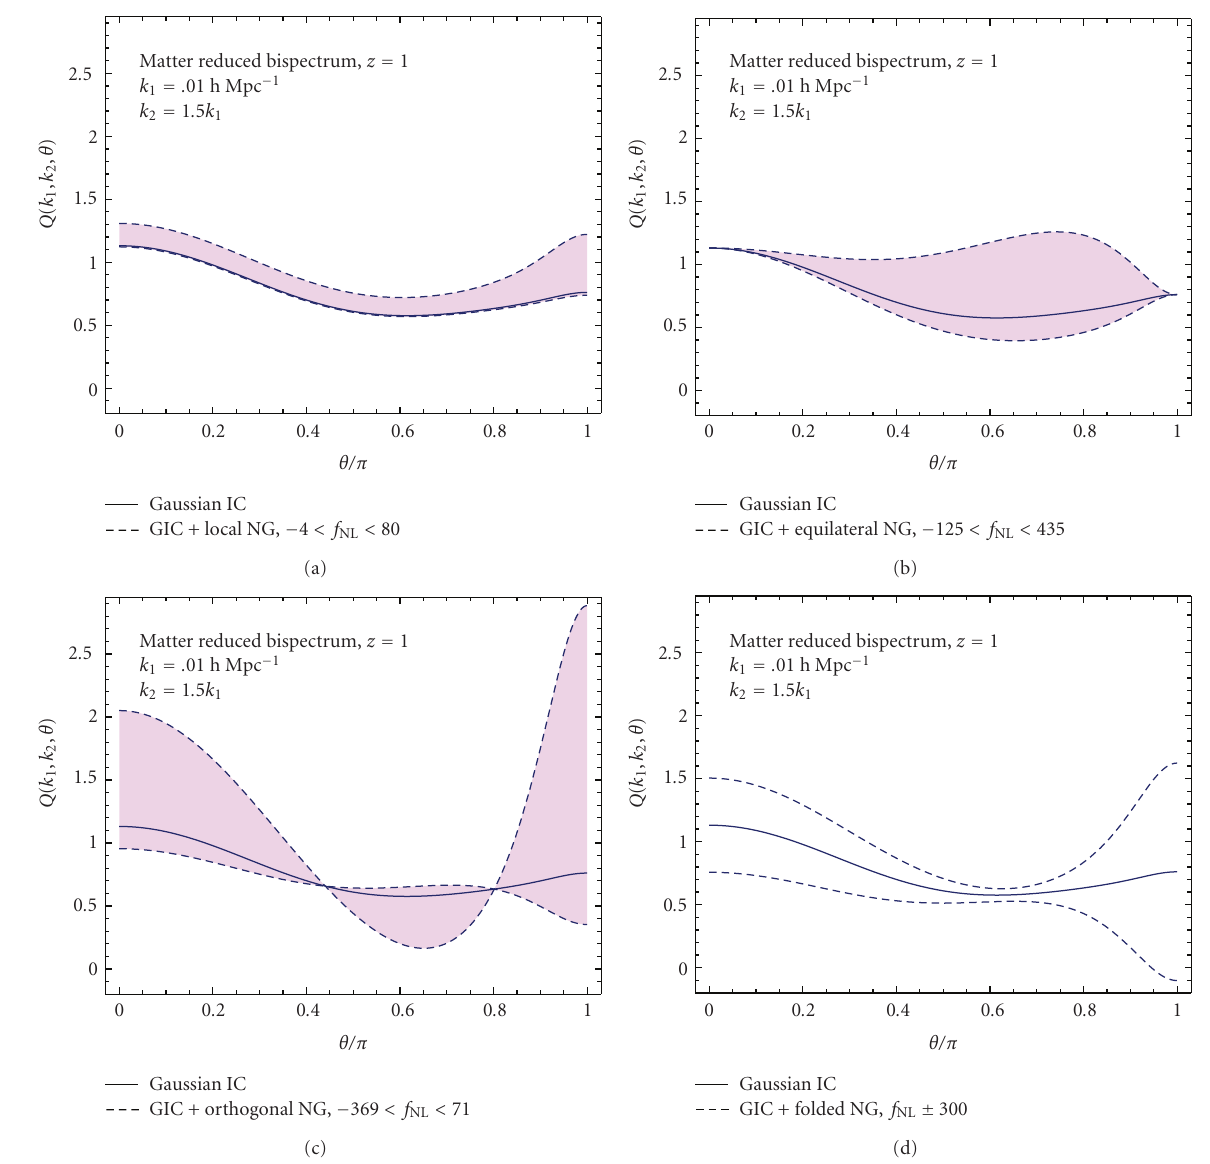
Figure 16: E ff ect of the primordial component for di ff erent non-Gaussian models on the matter reduced bispectrum, as a function of the triangle shape. The continuous line shows the reduced bispectrum Q ( k 1 , k 2 , k 3 ) at tree level in PT for Gaussian initial conditions at redshift z = 1 assuming k 1 = 0 . 01 h Mp c − 1 , k 2 = 1 . 5 k 1 as a function of the angle θ between k 1 and k 2 . Dashed lines show the reduced bispectrum including the primordial component for the local (a), equilateral (b), orthogonal (c), and folded (d) models. For the local, equilateral, and orthogonal models we assume the values of f NL corresponding to the 95% C.L. limits as determined by Smith et al. [68] and Senatore et al. [18] from WMAP observations. The shaded area indicates the currently allowed region. For the folded model, for which no observational constraints are available, the values f NL = ± 300 are